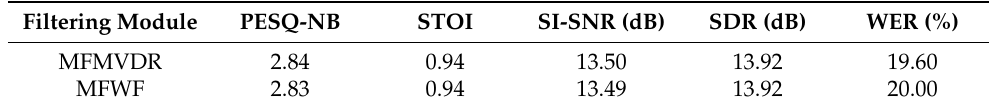
Table 3. The performance of the proposed system with different filtering modules. Filtering